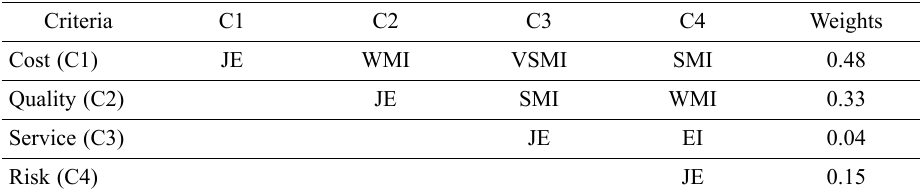
Table 3. Local weights and pairwise comparison matrix of main criteria